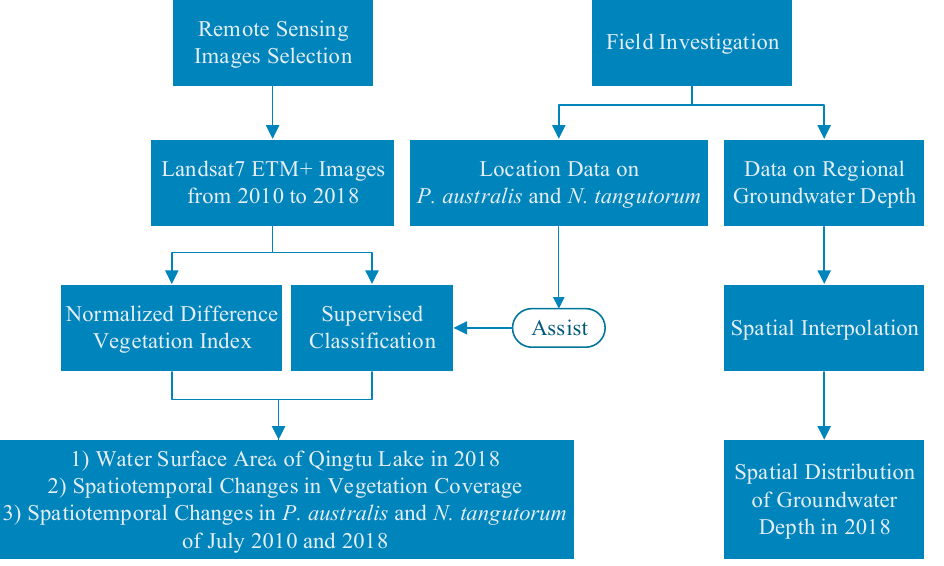
Figure 2. Study technology roadmap.